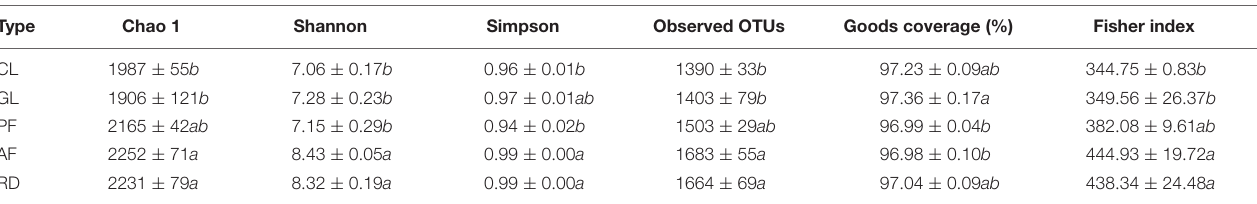
FIGURE 2 | Comparison of the quantitative contribution of the sequences affiliated with different bacterial phyla to the total number of sequences from five ecological types. Sequences not classified to any known phylum are included as unassigned bacteria. In each ecological type, bacterial phyla with a largest relative frequency of less than 0.1% are included as others. TABLE 2 | Mean alpha diversity in five ecological